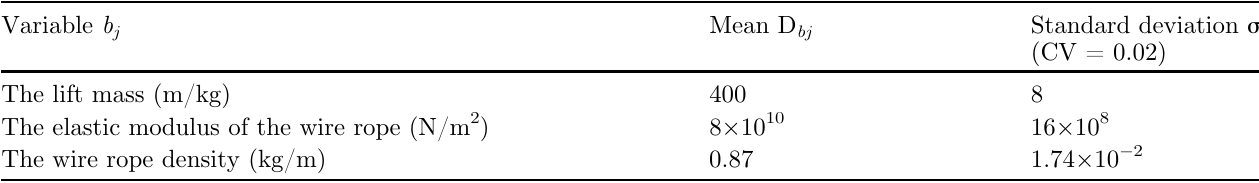
Table 2. HELS random parameter value.